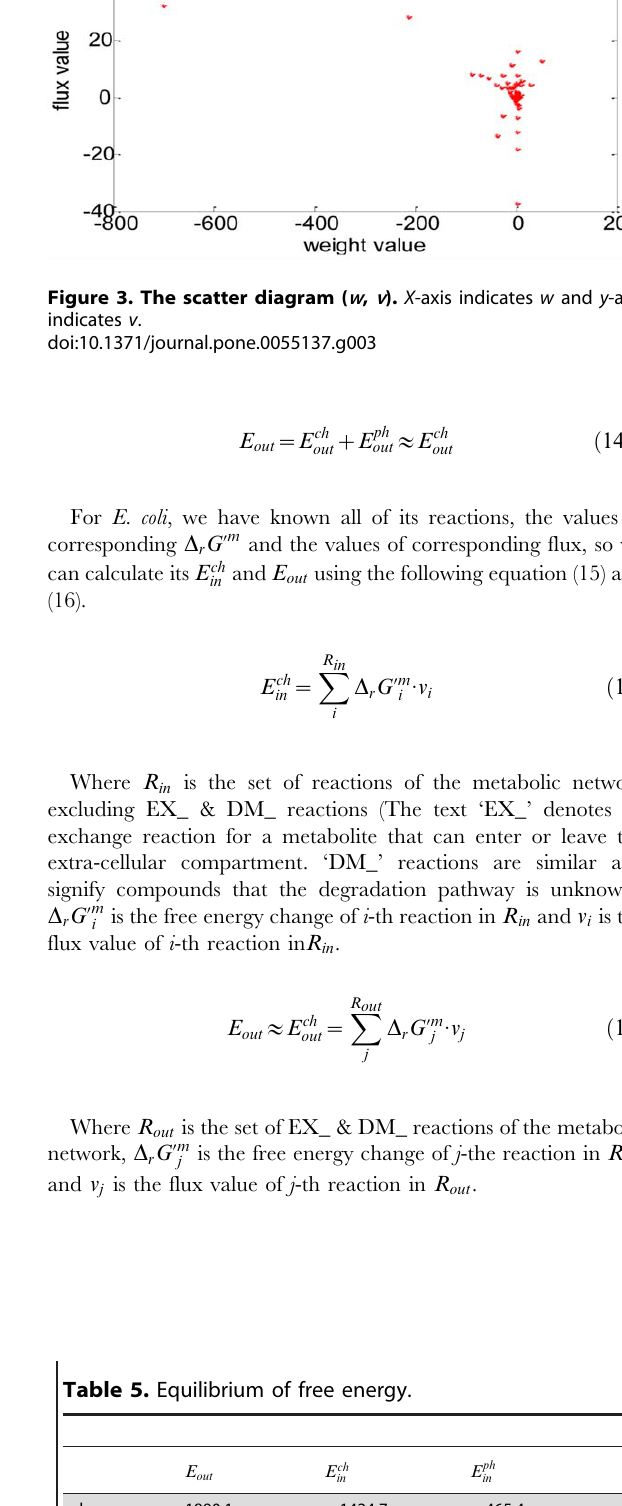
Table 5. Equilibrium of free